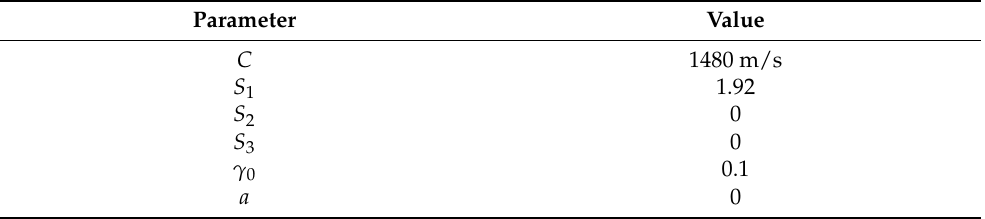
Table 2. Parameters used in Gruneisen EOS for the mallard bird model [11].